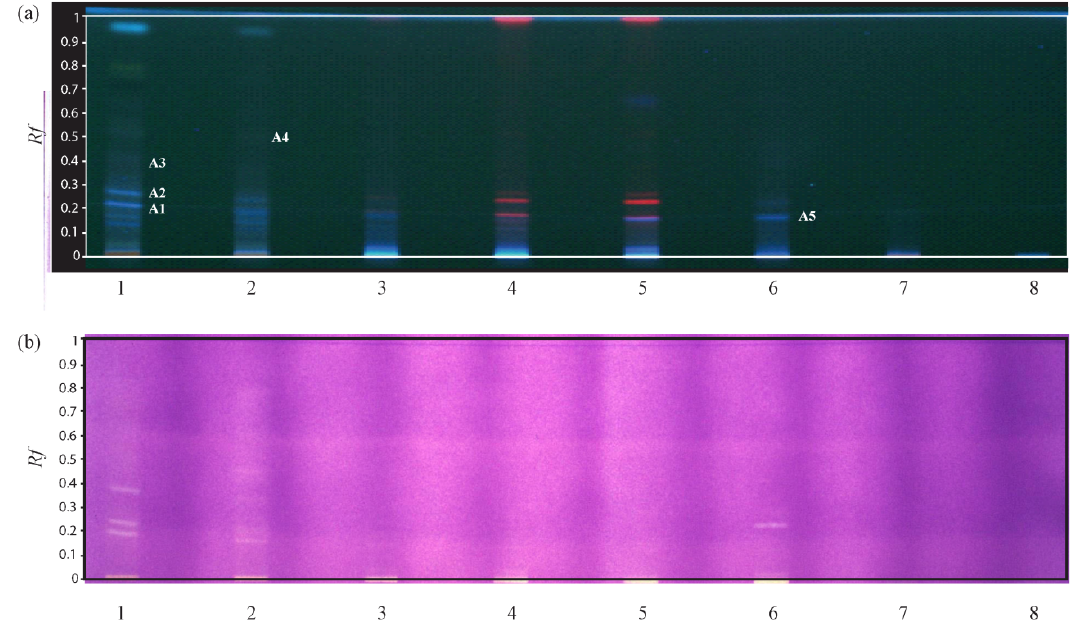
Figure 1. HPTLC analysis, tracks 1–7: G. saharae methanolic extracts of samples 1–7. Track 8: purified 5-methoxy-4',7-trihydroxy-8-glucopyranosylisoflavone ( a ) HPTLC detection at 366 nm; ( b ) Picture of the plate after reaction with